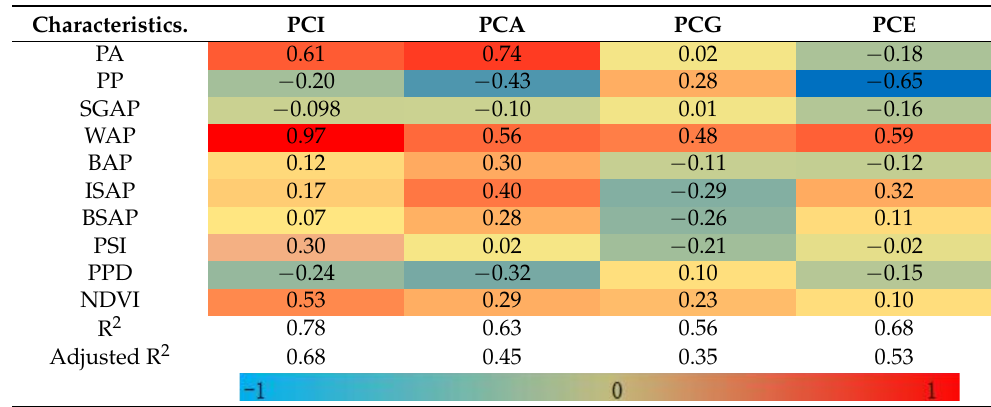
Table 6. Regression results of landscape metrics, NDVI, and PCI, PCA, PCG, and PCE. R 2 represents the proportions of the park cooling island variations that can be explained by the model. Colors represent the relative contribution of each metric to variations in the park cooling island. Red and blue represent positive and negative effects,